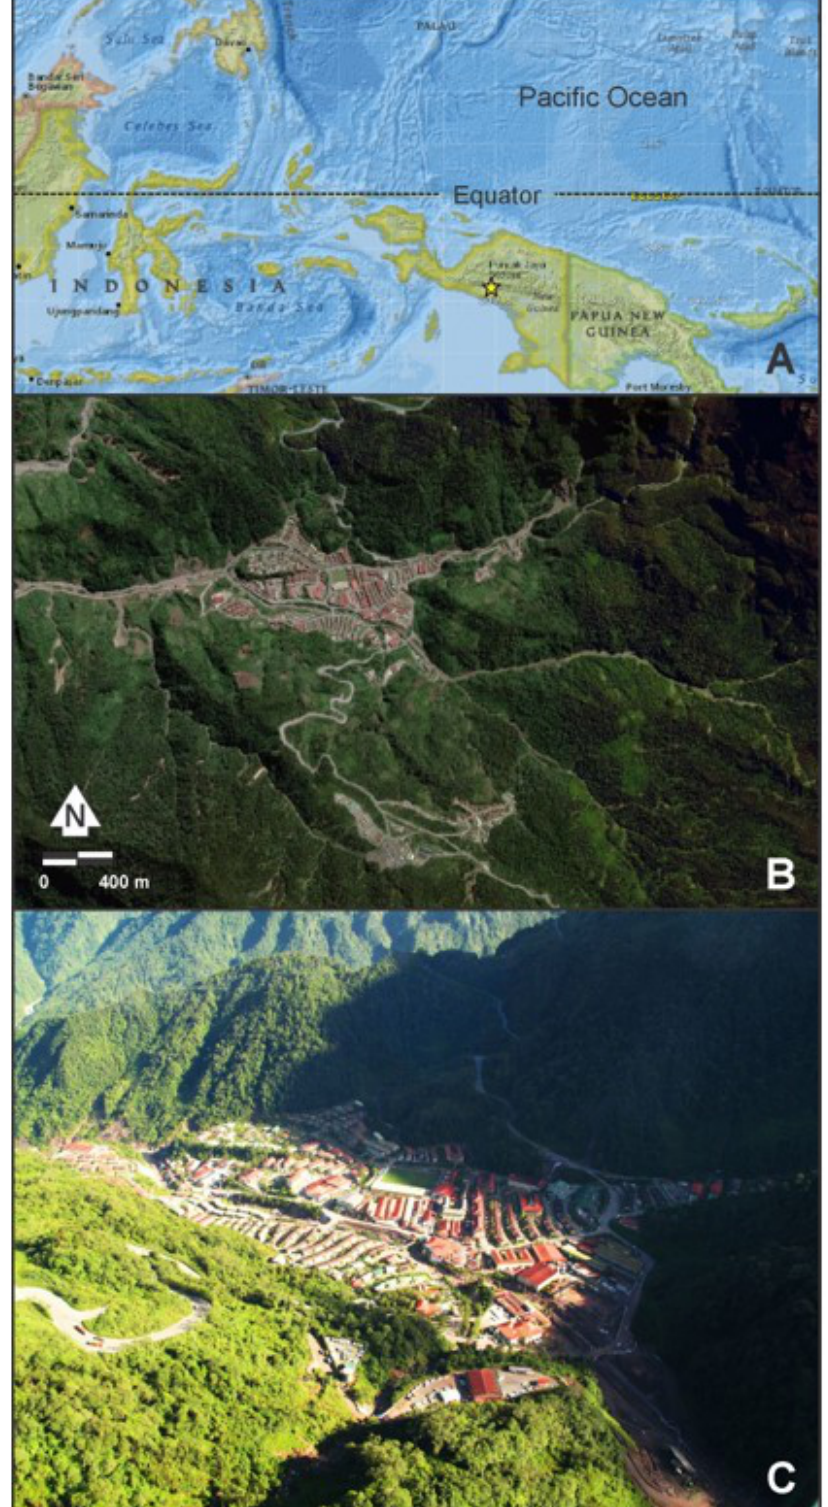
Figure 7. Tembagapura located in the province of Papua, Indonesia. (a) Regional view, yellow star indicates Tembagapura (image © ESRI and National Geographic World Map), (b) vertical image over Tembagapura showing debris flows and debris floods (image © Google Earth), (c) oblique view of Tembagapura in the steep Jayawijaya